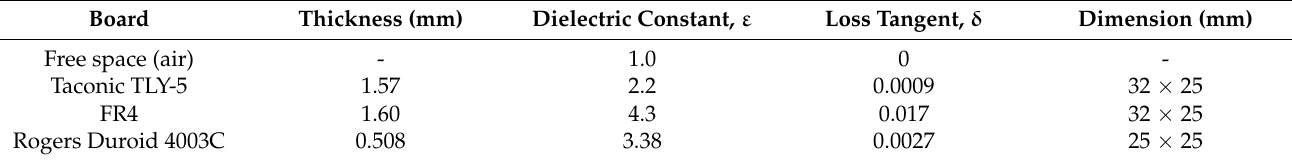
Table 4. MUT samples and their